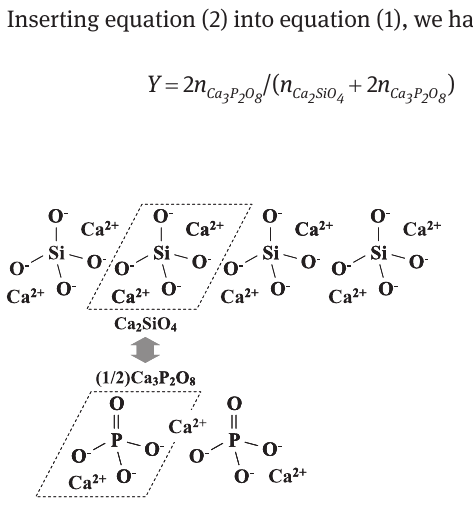
Fig. 2: Schematic illustration of solid solution between Ca 2 SiO 4 and Ca P O 3 2 8